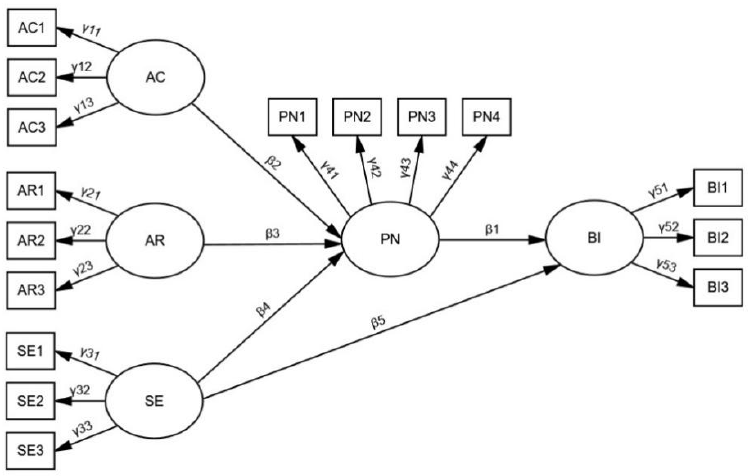
Figure 2. Model. Note: The “ellipse” indicates a latent variable; the “rectangle” indicates an observable variable; and the “single arrow” indicates a causal relationship.